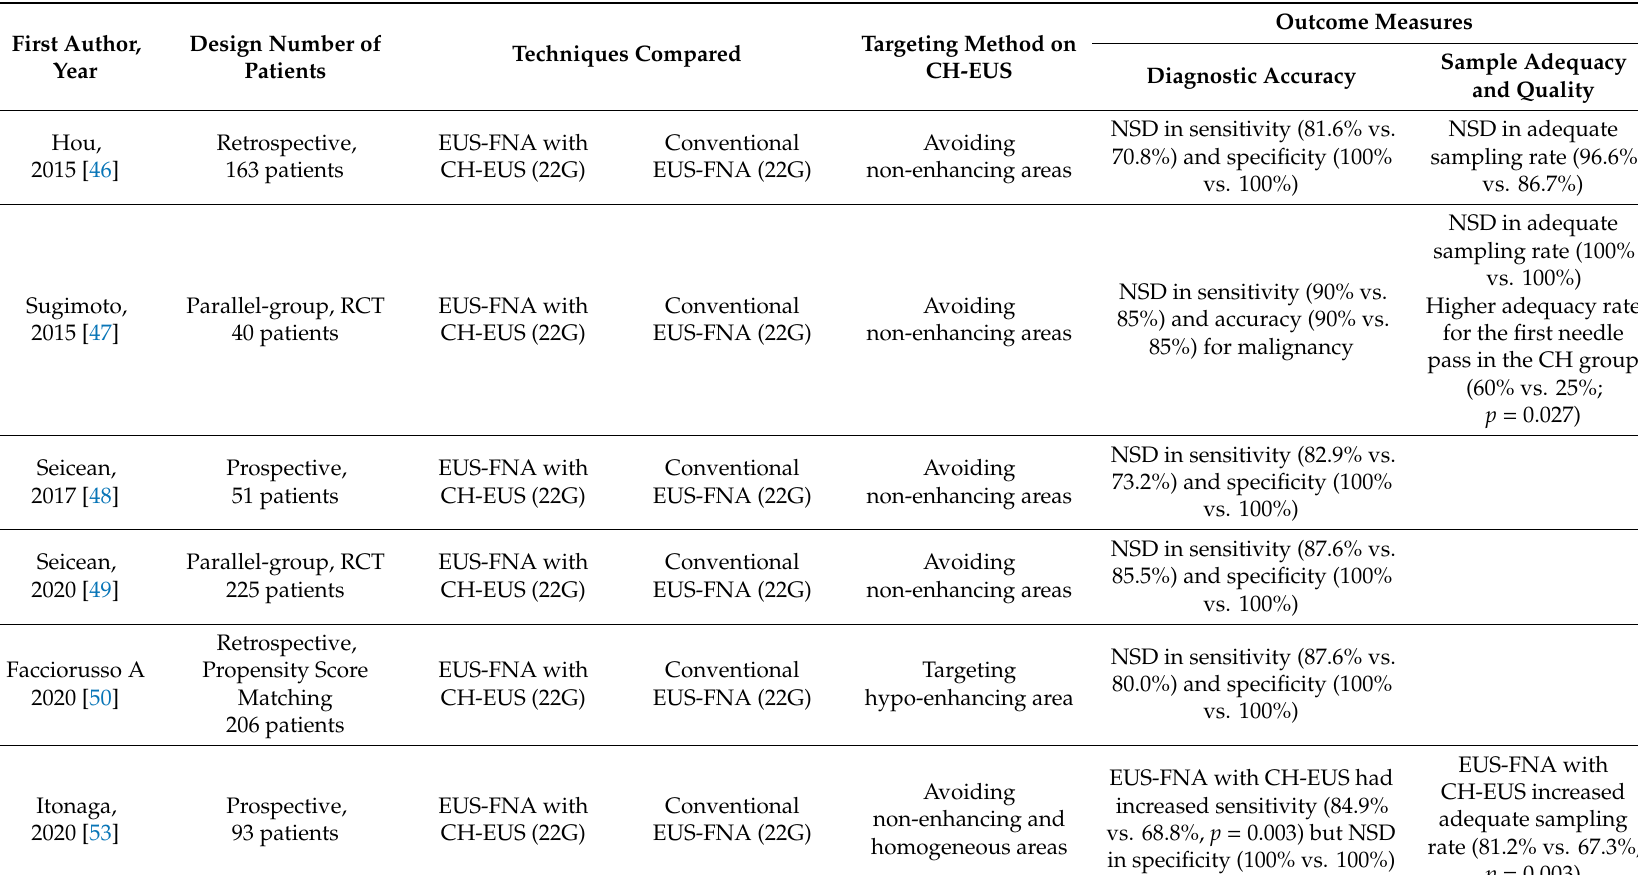
Table 1. Targeting endoscopic ultrasound-guided fine-needle aspiration (EUS-FNA) with contrast-enhanced harmonic (CH)-EUS for pancreatic solid